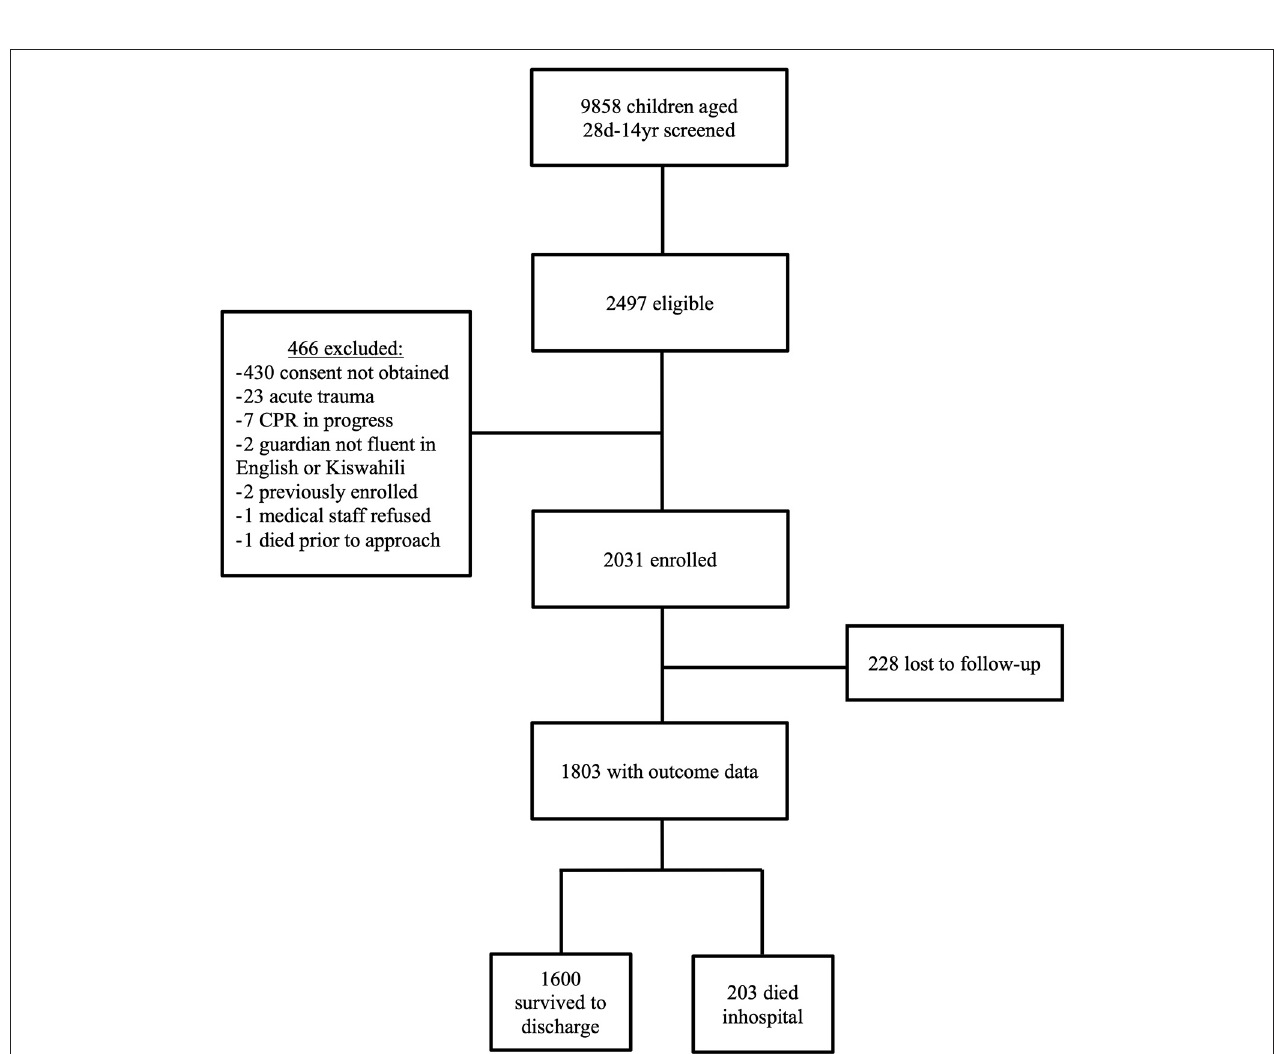
FIGURE 2 | Flow-chart depicting enrollment for this study, including criteria for exclusion, children lost to follow-up, and mortality outcomes.